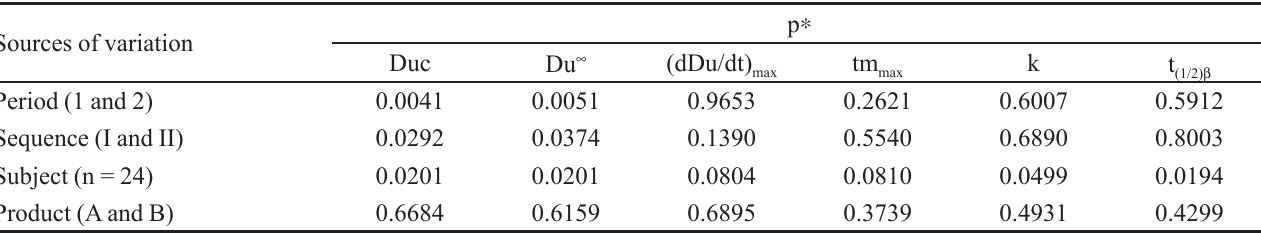
TABLE IV - Values of p obtained after statistical analysis (ANOVA) of ln -transformed data for the following pharmacokinetic parameters: cumulative amount of cephalexin excreted ( Duc ); total cumulative amount of cephalexin excreted ( Du ∞ ); maximum rate excretion of cephalexin [ (dDu/dt) ]; middle-time of maximum excretion rate of cephalexin ( tm max